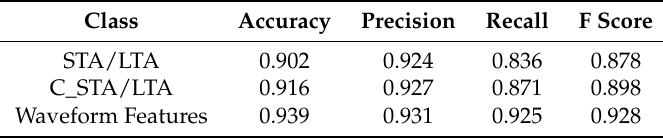
Table 6. Efficiency of various